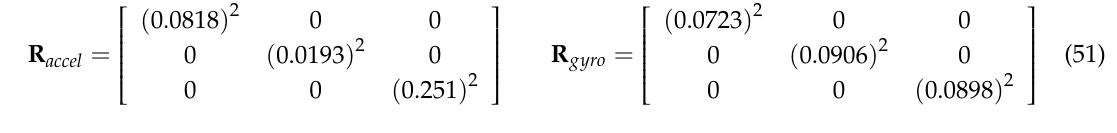
Figure 16. Comparison of IMU measurement and filtered data.